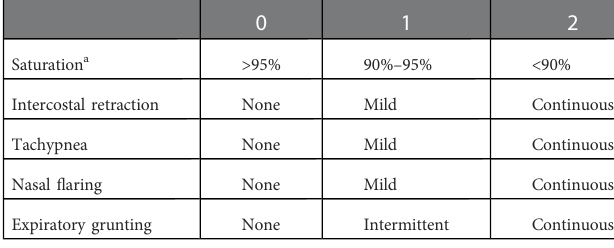
TABLE 1 Modi fi ed TTN Silverman